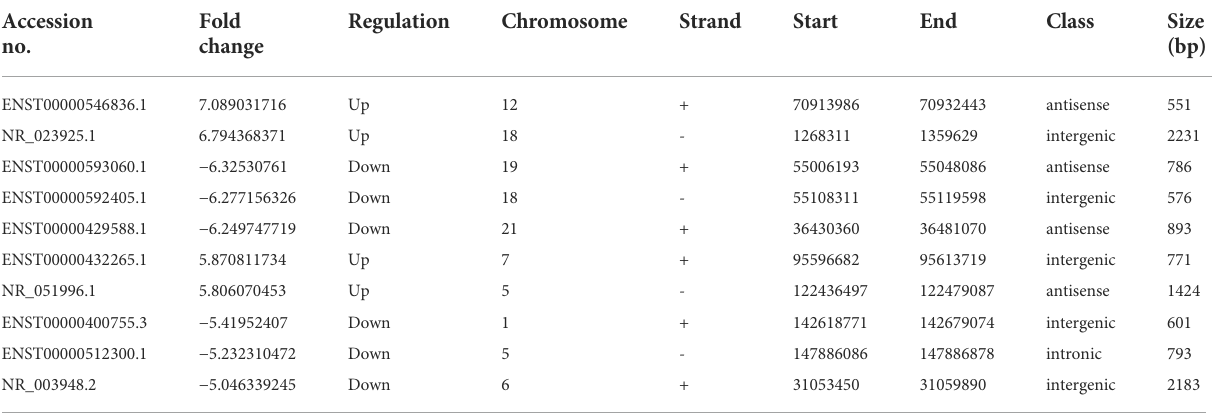
TABLE 2 The characteristics of the top 10 LncRNA with largest fold change. Accession